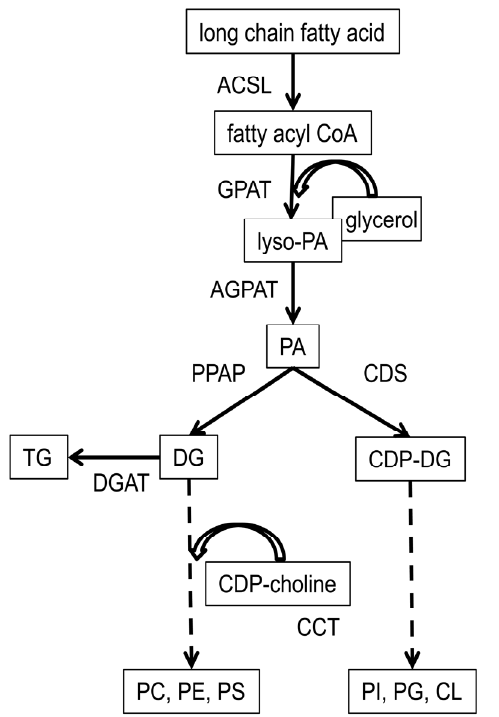
Figure 4. Biosynthetic pathway of major phospholipids in vascular endothelial tissue and mononuclear leukocytes. Metabolites are boxed, enzymes are unboxed. Note that